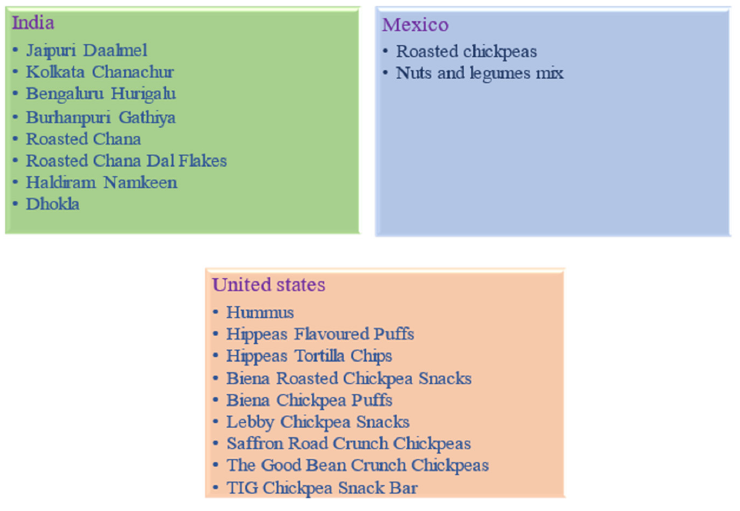
Figure 3. Value-added products of